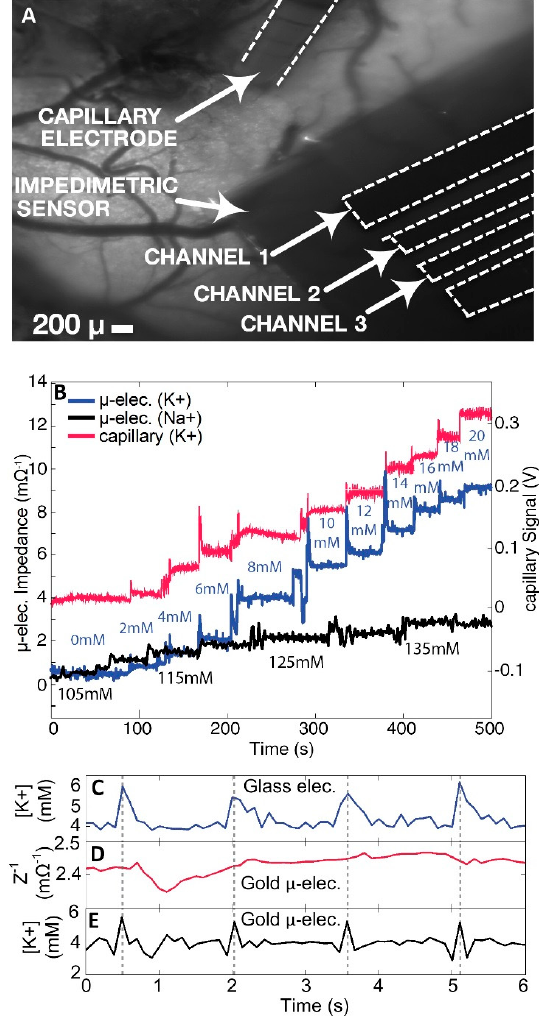
Figure 4. ( A ) raw fluorescence image of mouse cranial exposed window, with 10X magnification: the glass capillary electrode ( top ), and monolayer gold coated electrode ( right ); ( B ) calibration curve of both the glass capillary electrode ( red ) and coated gold microelectrode ( blue ) for varying concentrations of KCl and NaCl. Sodium concentrations were also evaluated for the gold microelectrode using NaCl in simulated CSF to determine alternative cation sensitivity. While a slight increase in signal was achieved, it was not as significant as for potassium. Simulated CSF solutions containing 2.5–22.5 mM KCl were changed in 2 mM increments. Each solution also contained: NaCl 120 mM, glucose 10 mM, NaHCO 3 22 mM, and 2.6 mM NaH 2 PO 4 ·H 2 O, MgSO 4 and CaCl 2 . The pH was adjusted to 7.4. The potassium-sensitive glass capillary electrode was connected to the same power supply set as the gold microelectrode, which had a built-in voltage gain to amplify the signal, resulting in heightened sensitivity to the cation concentration; ( C – E ) In vivo recordings of extracellular potassium during optogenetically elicited responses for both glass capillary ( blue ) and coated gold microelectrodes ( black ). Raw impedance recordings for the coated gold microelectrode were also represented for comparison ( red ). A blue light driver was pulsed every 1.5 s to initiate a potassium spike. Gold microelectrode measurements were recorded at 300 Hz.